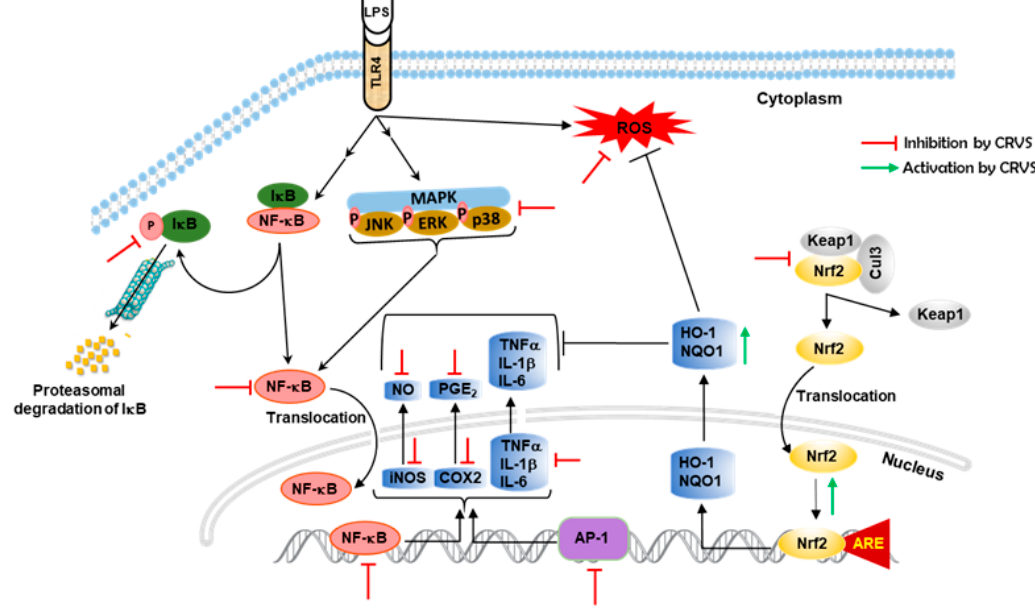
Figure 6. Schematic diagram of the mode of action of CRVS against inflammation in LPS-induced macrophages.